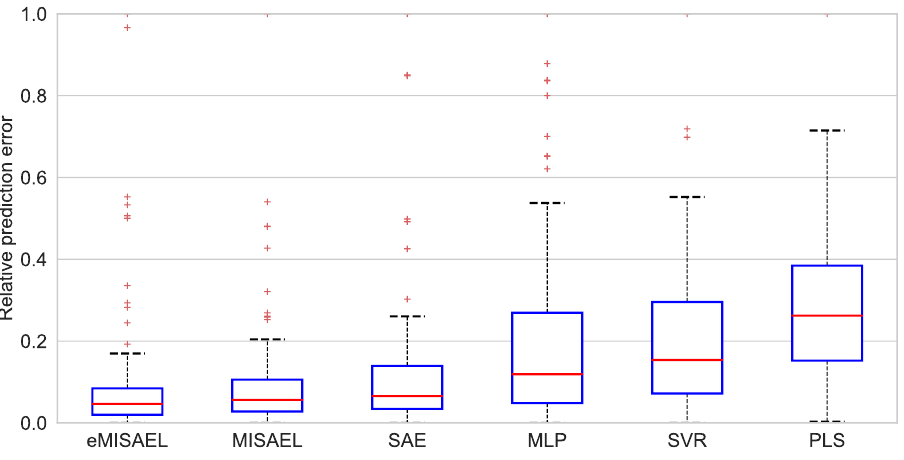
Figure 9. Relative prediction error of testing results for debutanizer column process using eMISAEL, MISAEL, SAE, MLP, SVR, and PLS models,